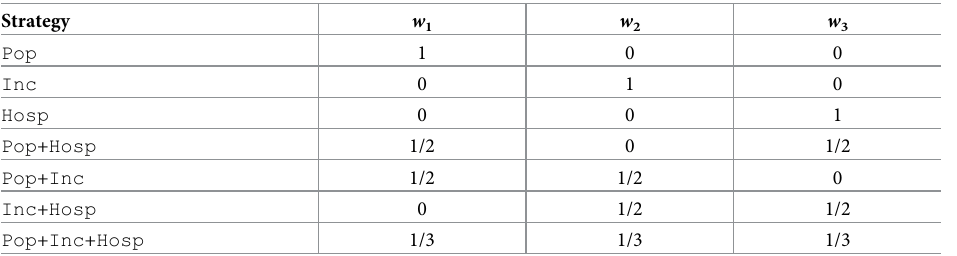
Table 4. Adaptive vaccination strategies and their corresponding weights corresponding to (10). Pop , Inc and Hosp refer to strategies where vaccines are distributed demographically, based on the regional incidence level only, and based on the number of hospitalized cases only,